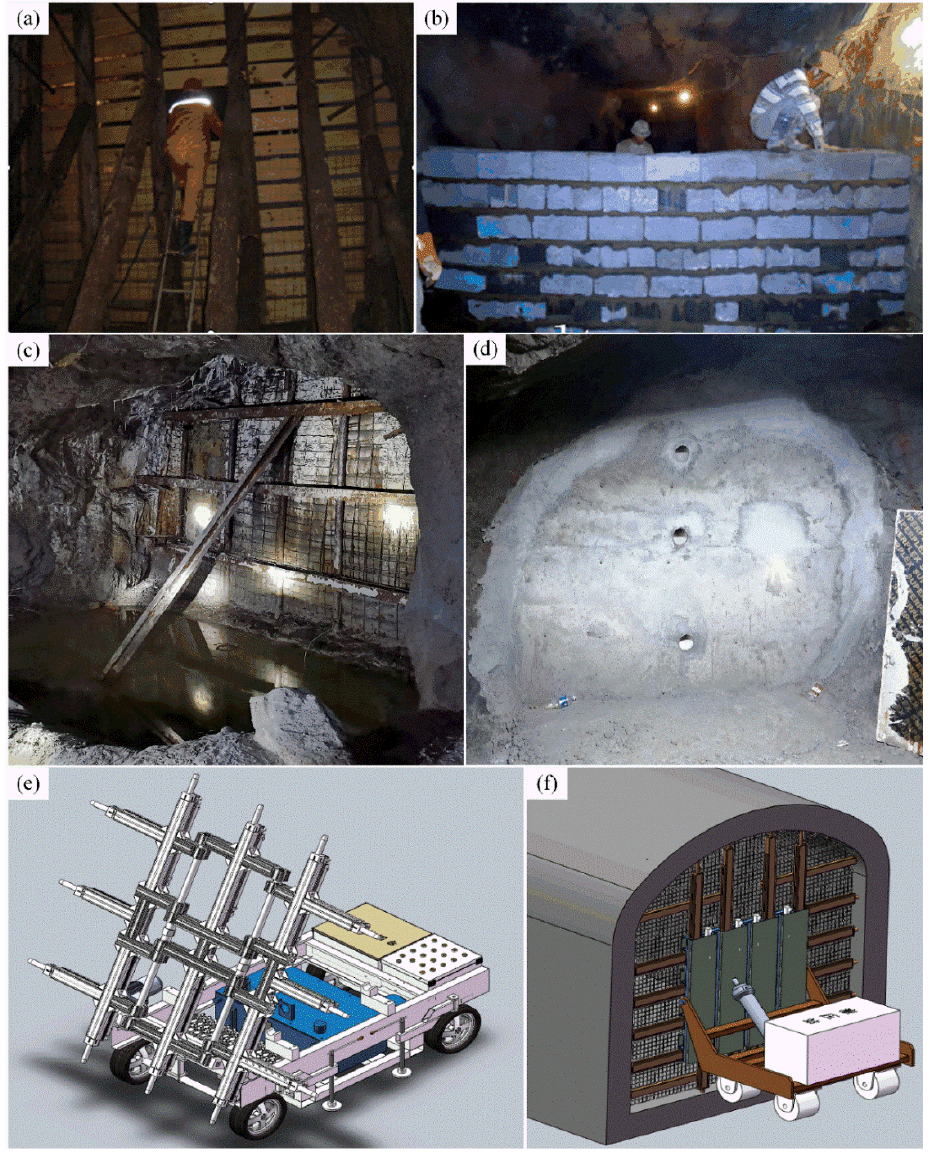
Figure 6. Schematic diagram of common filling retaining wall: ( a ) Wooden filling retaining wall; ( b ) Brick retaining walls; ( c ) Steel mesh flexible filling retaining wall; ( d ) Concrete retaining walls; ( e ) Hydraulic filling retaining wall trolley; ( f ) Hydraulic filling retaining wall.